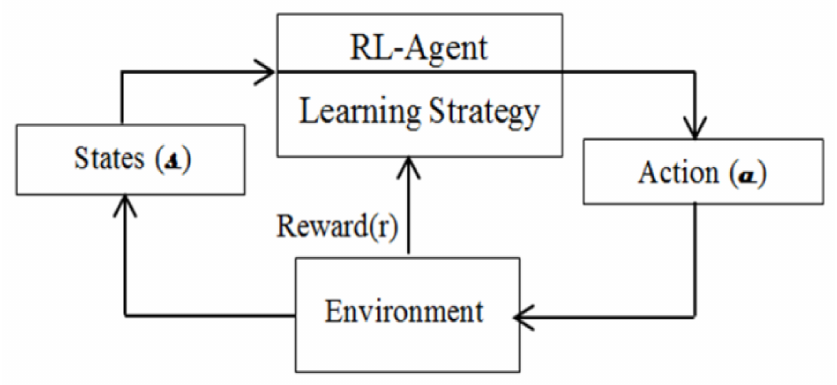
Figure 1. RL based on the